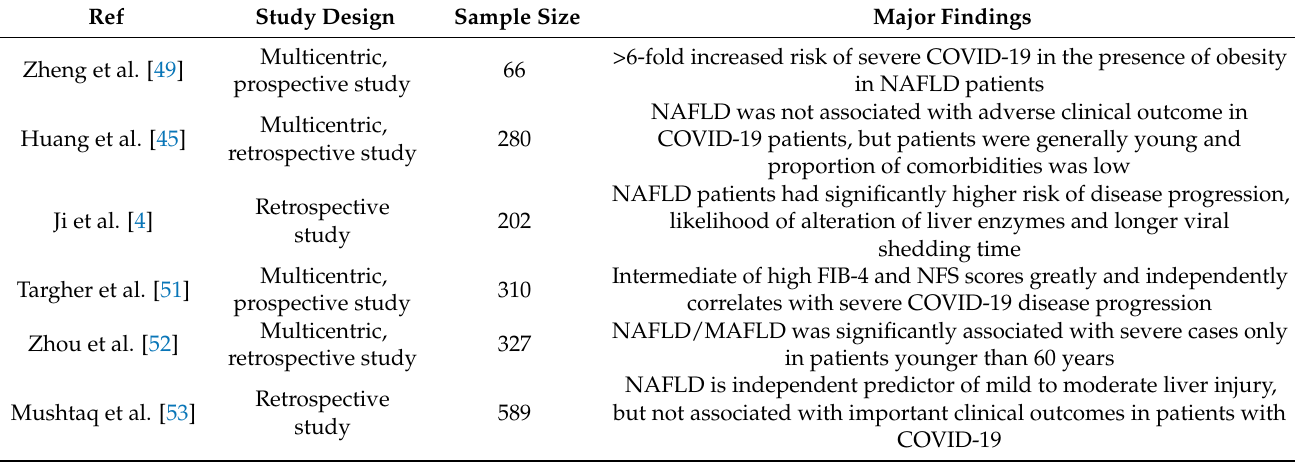
Table 1. Studies that investigated the connection between NAFLD and